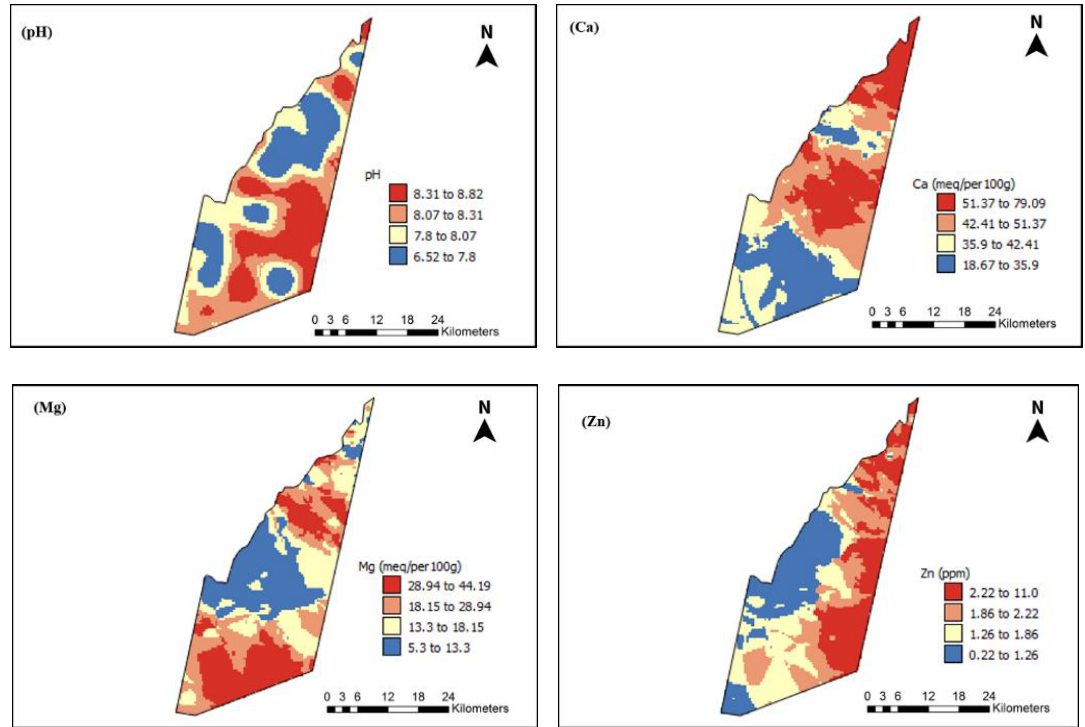
Figure 5. Spatial variability maps of soil pH, Ca, Mg and